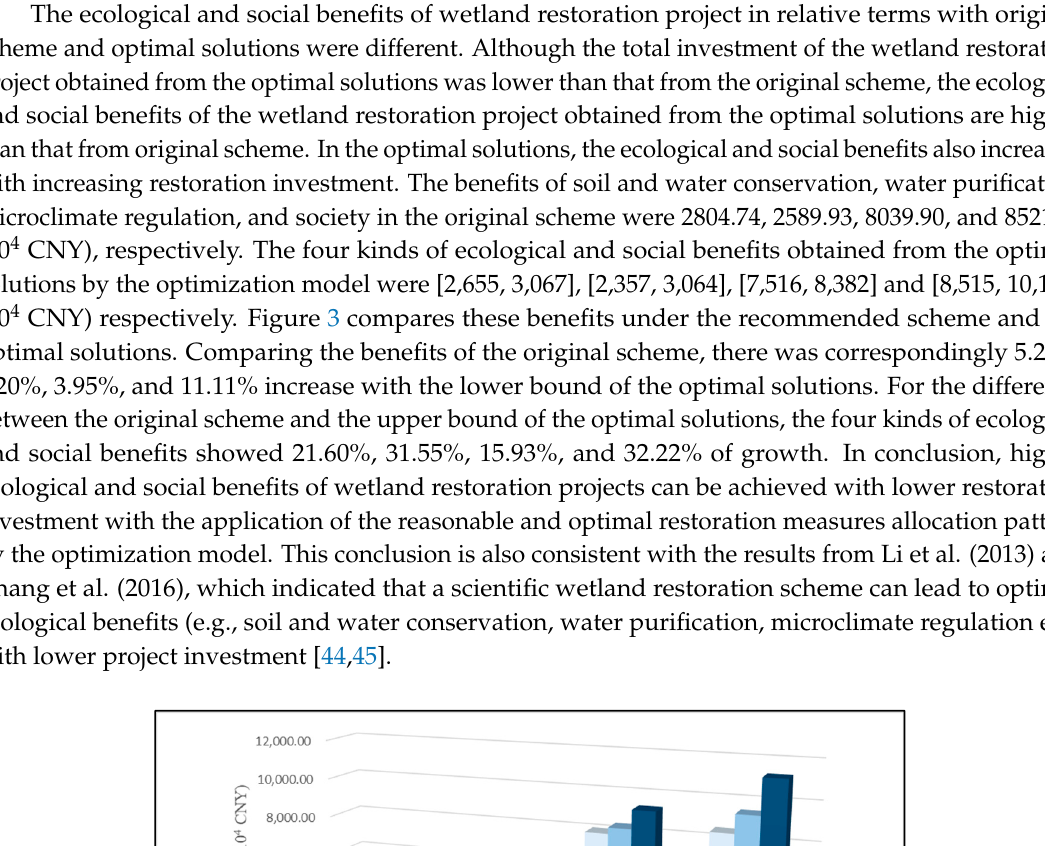
Figure 2. The wetland restoration measures between the original scheme and optimal solutions.